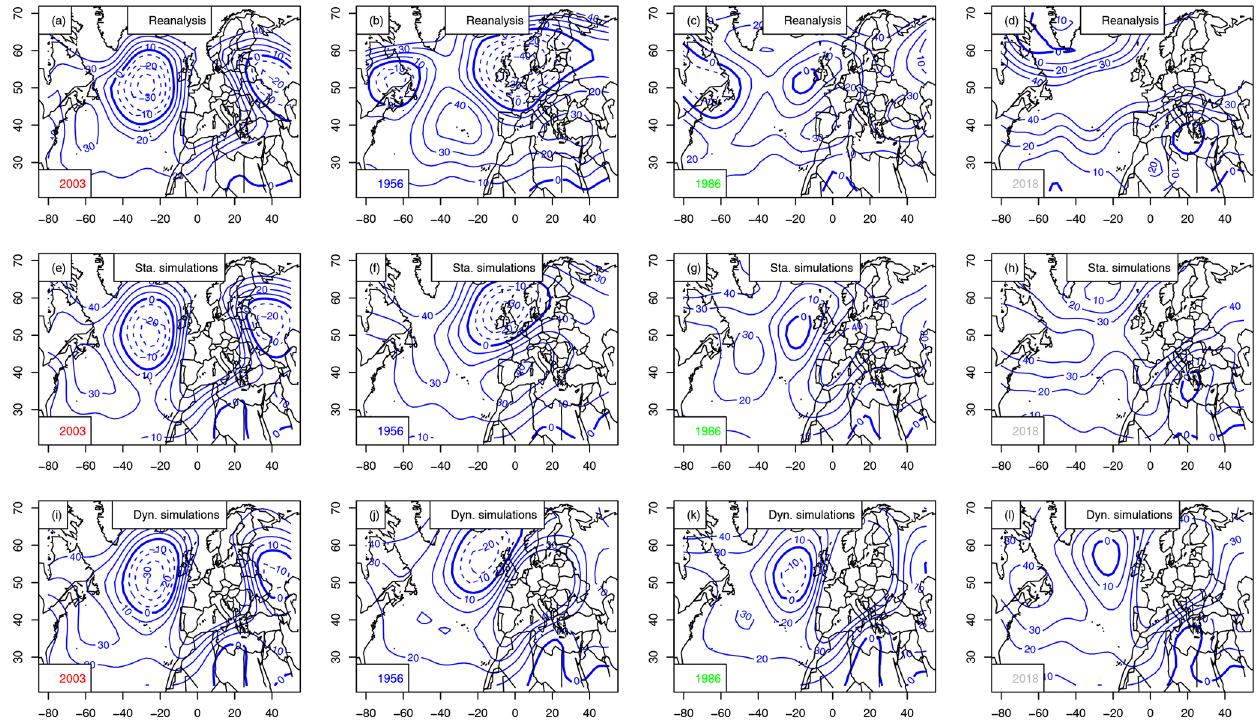
Figure 8. Z500 anomaly composites (in meters, with 10m increments) for the warmest summer (2003), coolest (1956), median (1986) and 2018, for European averages. The 0m isoline is indicated with a thick blue line. Negative anomalies are in dashed isolines. Horizontal axes are for longitudes in degrees east. Upper row (a–d) : mean Z500 from NCEP reanalyses. Center row (e–h) : static simulations. Bottom row (i–l) : dynamic